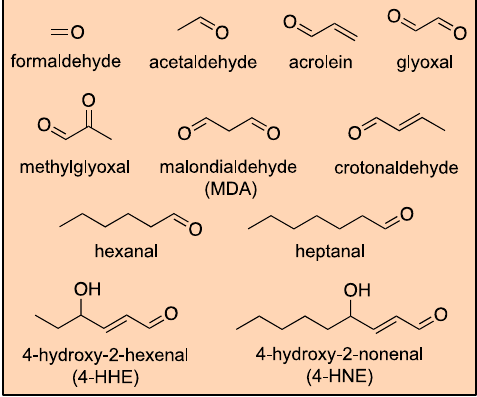
Figure 2. Structures of common aldehydes associated with various human diseases.